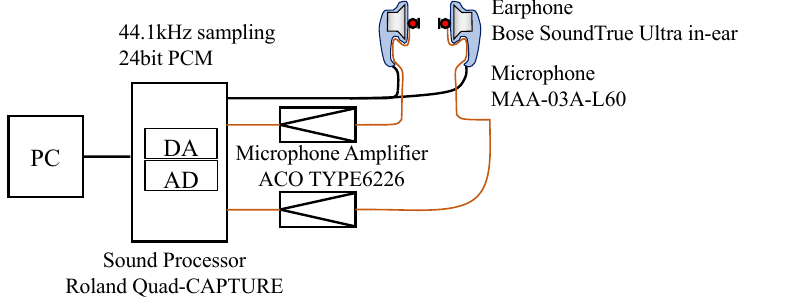
Figure 2. The measurement system for measuring bilateral ear data.